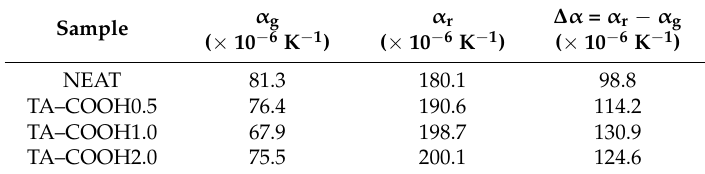
Table 2. Linear coefficients of thermal expansion determined from TMA